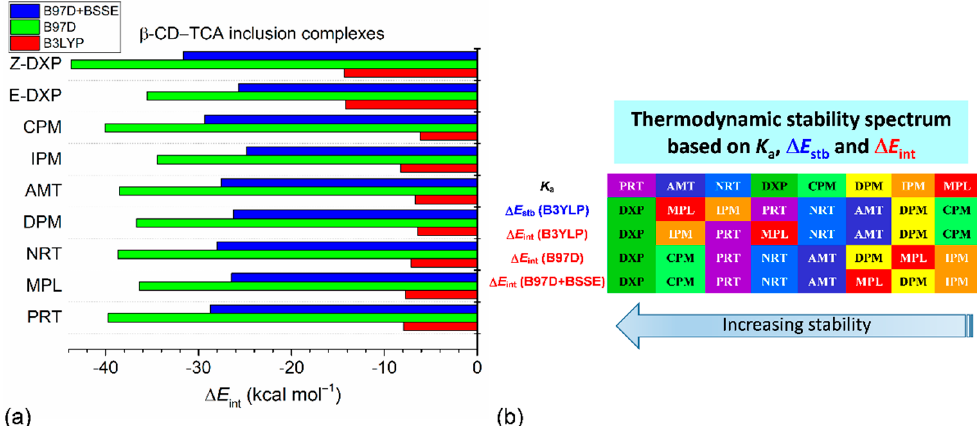
Figure 10. ( a ) Interaction energies ( Δ E int s) of eight β -CD–TCA base inclusion complexes derived in the gas phase, with mixed basis sets 6-31+G*/4-31G using various DFT methods, that is, without dispersion correction (B3LYP), with dispersion correction (B97D), and with dispersion and BSSE corrections (B97D+BSSE). ( b ) Thermodynamic stability spectrum based on K a [20,27,29], Δ E stb, and Δ E int of eight β -CD–TCA base inclusion complexes. DXP denotes the racemic mixture of Z - and E -enantiomers for K a and the most stable complex of Z -DXP for ∆ E . The estimated uncertainties of ∆ E = 0.1 kcal mol − 1 ; see also Figure 9 and Tables S7–S9.